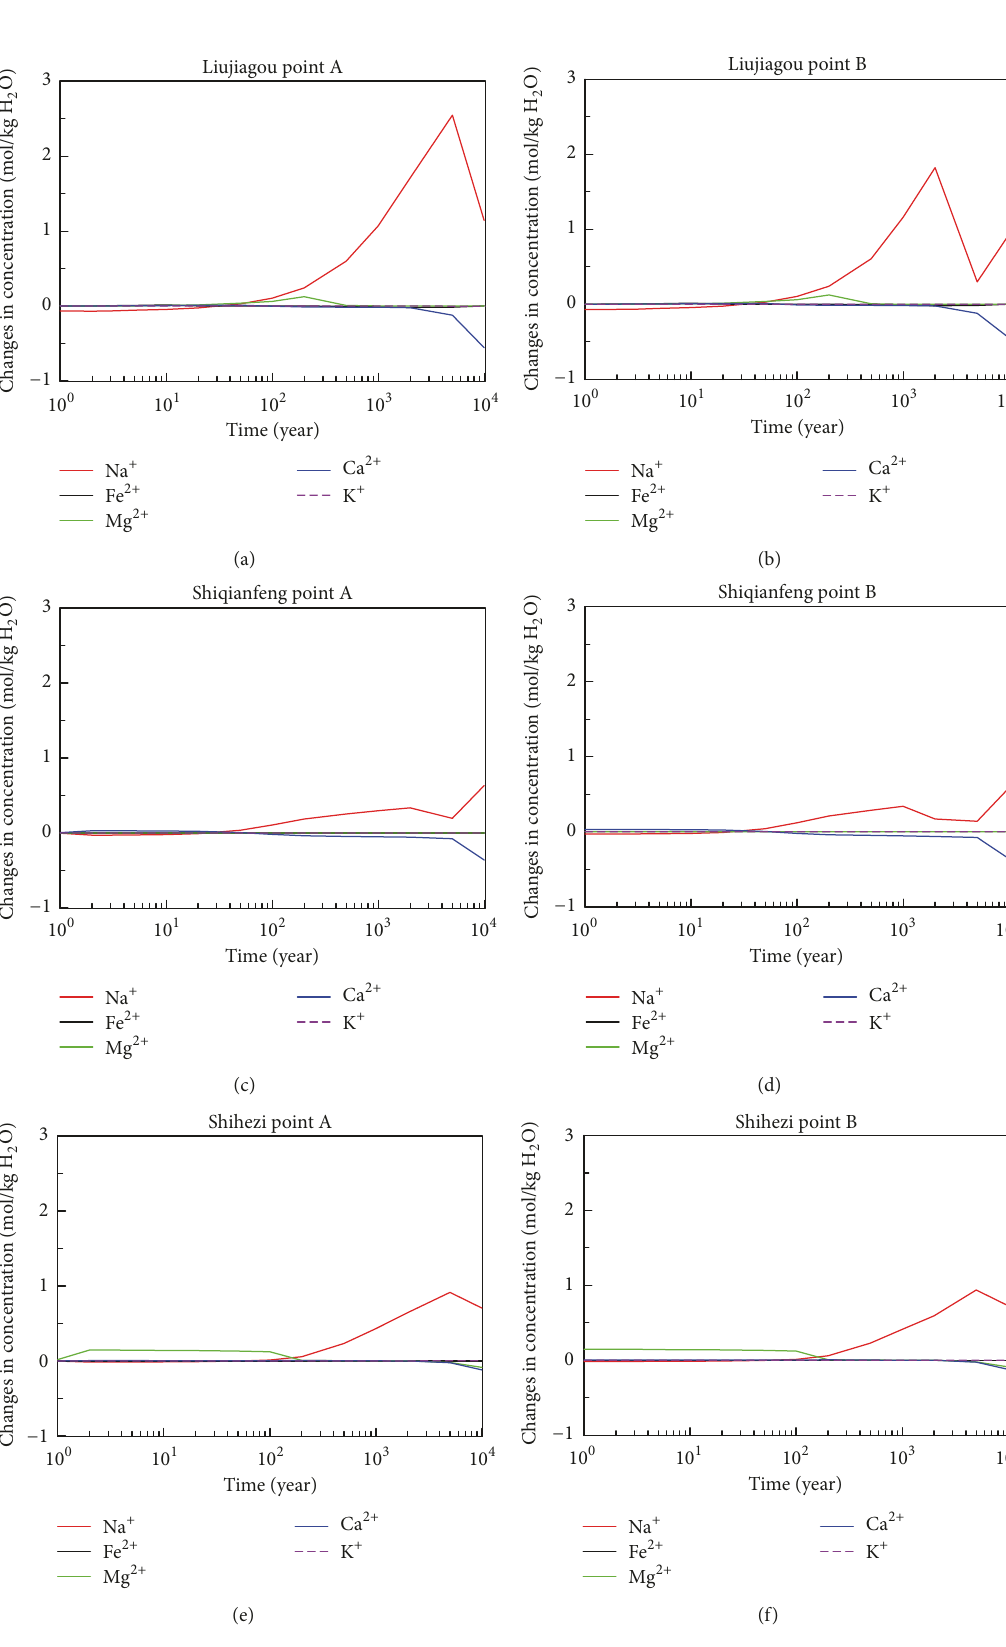
Figure 8: The evolution of changes in aqueous concentrations at points A and B for the Liujiagou formation (a, b), Shiqianfeng formation (c, d), and Shihezi formation (e, f) over